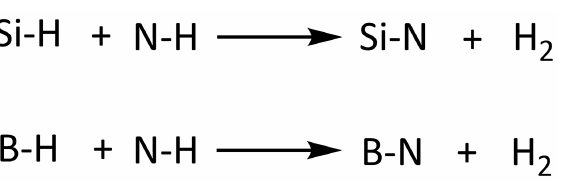
Figure 2. ( a ) TGA curves of PBSZ x:y pyrolyzed under Ar atmosphere and ( b ) TGA-MS curves of PBSZ0:1 pyrolyzed under Ar atmosphere.